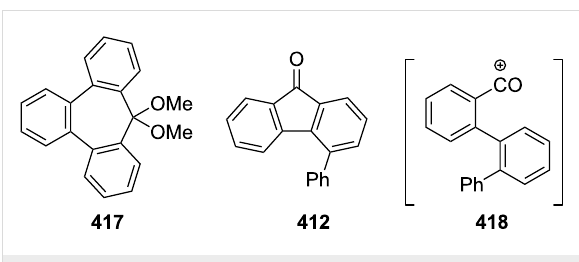
Figure 23: Structures of tribenzotropone dimethyl ketal 417 and 4-phenylfluorenone ( 412 ) and proposed intermediate 418